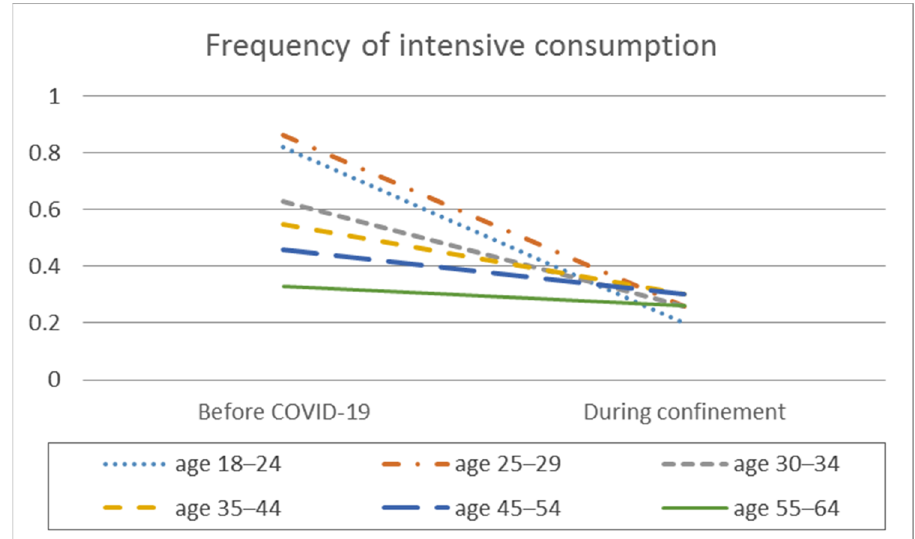
Figure 3. Frequency of intensive alcohol consumption by age before the pandemic and during COVID-19 confinement.